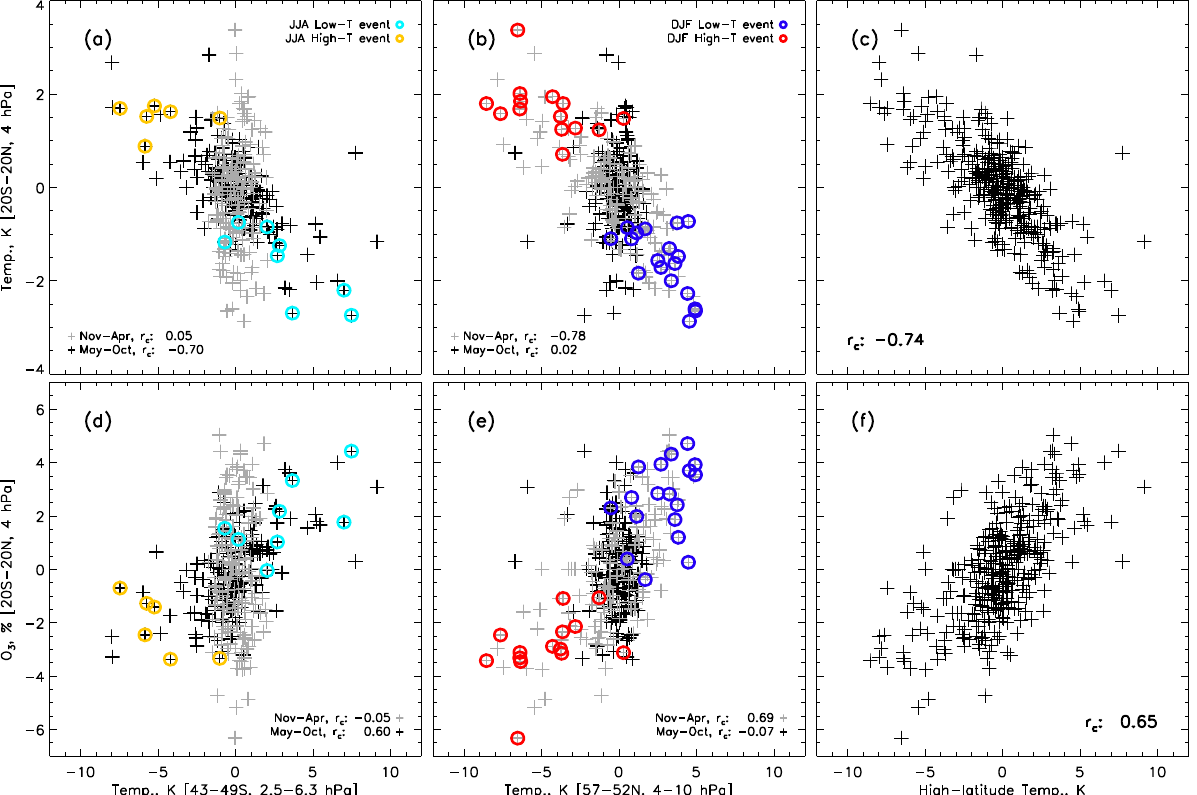
Figure 8. (a–b) SOCOL equatorial temperature anomalies (4hPa, 20 ◦ N–20 ◦ S) plotted against (a) temperature means from 2.5–6.3hPa and 43–49 ◦ S and (b) 52–57 ◦ N and 4–10hPa. (d–e) As for upper panels, but equatorial ozone anomalies (4hPa, 20 ◦ N–20 ◦ S) are instead plotted against high-latitude temperature anomalies. Grey crosses are for November–April months; black crosses for May–October; correlations for both periods are given in each panel. Red and blue circles identify the DJF high- T and low- T events in Figs. 1 and 2, respectively; orange and light-blue circles similarly identify JJA events. (c, f) May–October 43–49 ◦ S temperatures and November–April 52–57 ◦ N temperatures are combined in the right panel (UBDC index) and plotted against equatorial (c) temperature and (f) ozone.